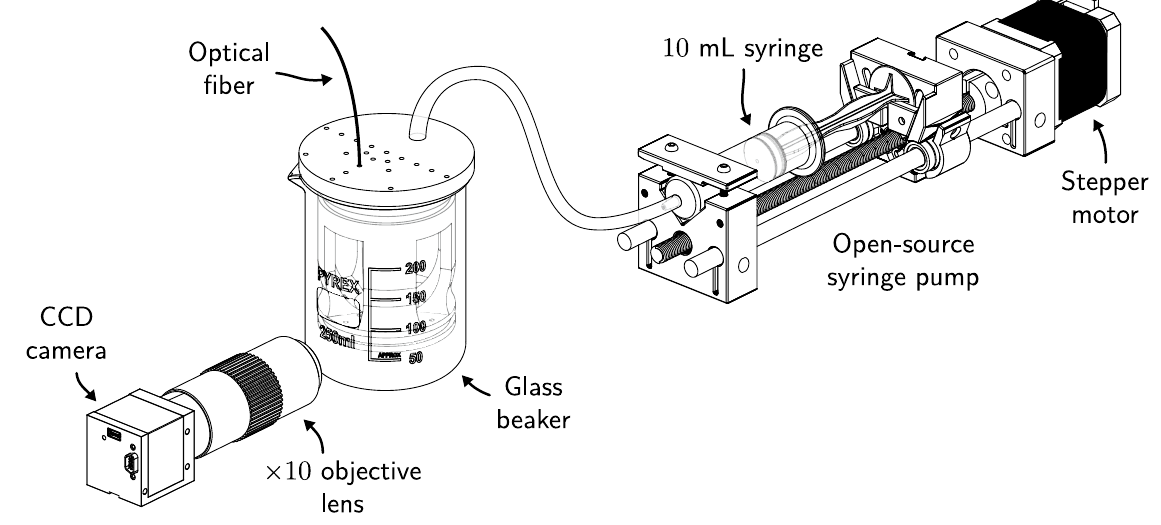
Figure 5. Depiction of the experimental setup used to regulate the liquid level in the hollow-core